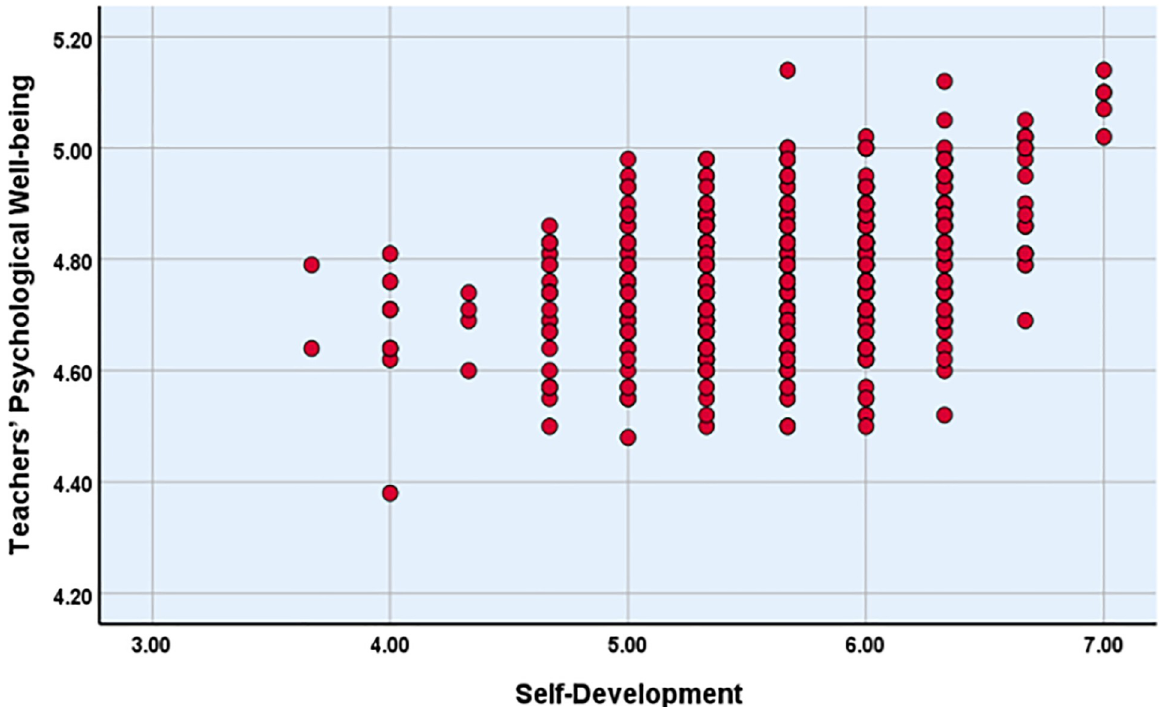
Fig 6. Pearson’s product-moment correlation between information sharing and teachers’ psychological well-being. The scatterplot indicates the significant positive relationship between information sharing (subdomain of leadership empowering behaviour) and Teachers’ psychological well-being at secondary